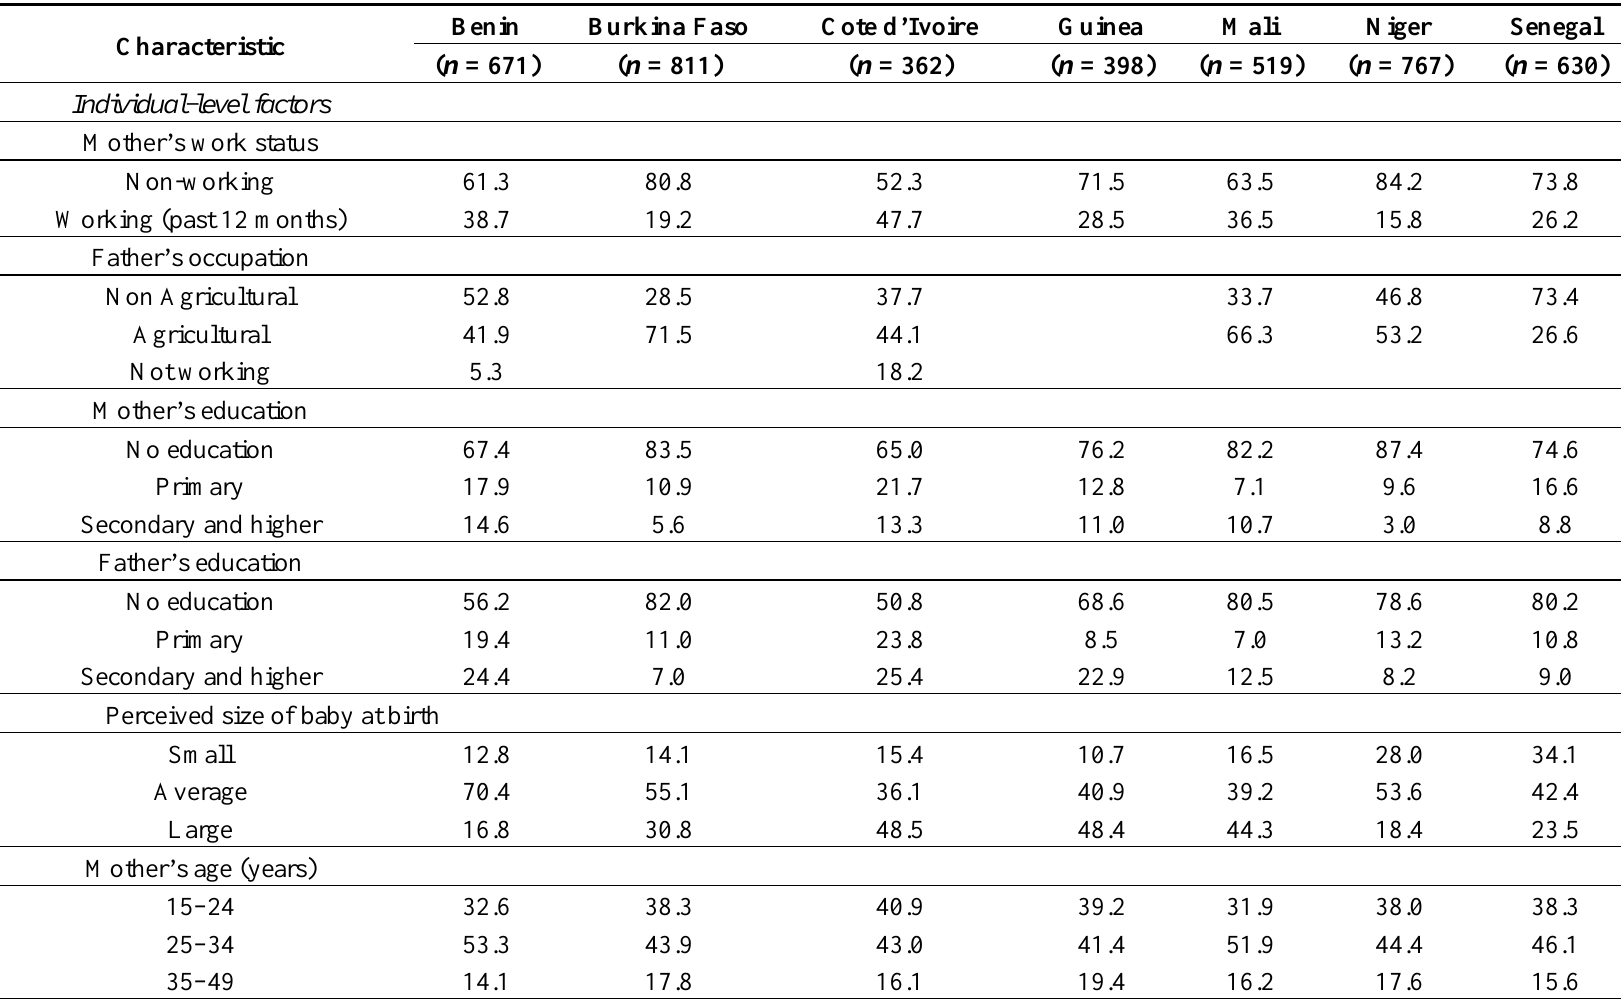
Table 1. Individual-, household- and community-level characteristics of infants aged three to five months in seven Francophone West African countries, 2010–2013 (in